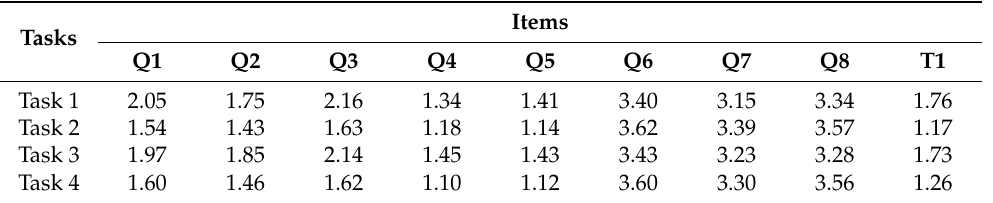
Table 2. Mean scores for all items used in the